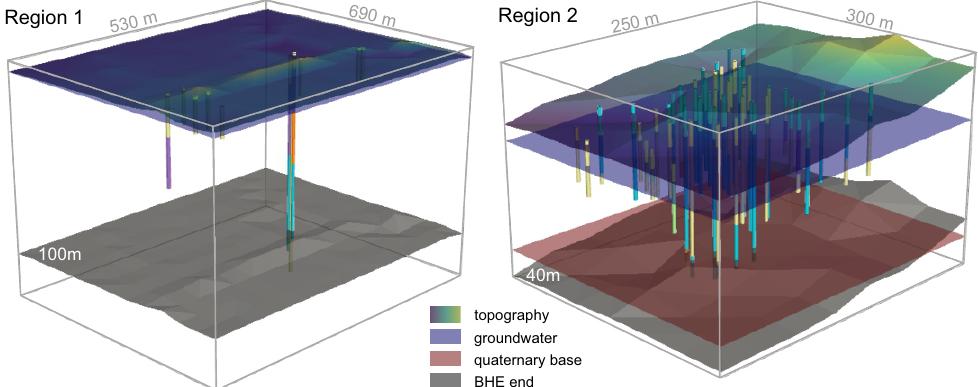
Figure 7. Input data for the two target regions, combined in a 3-D model. The legend of the borehole stratigraphies is shown in Figure